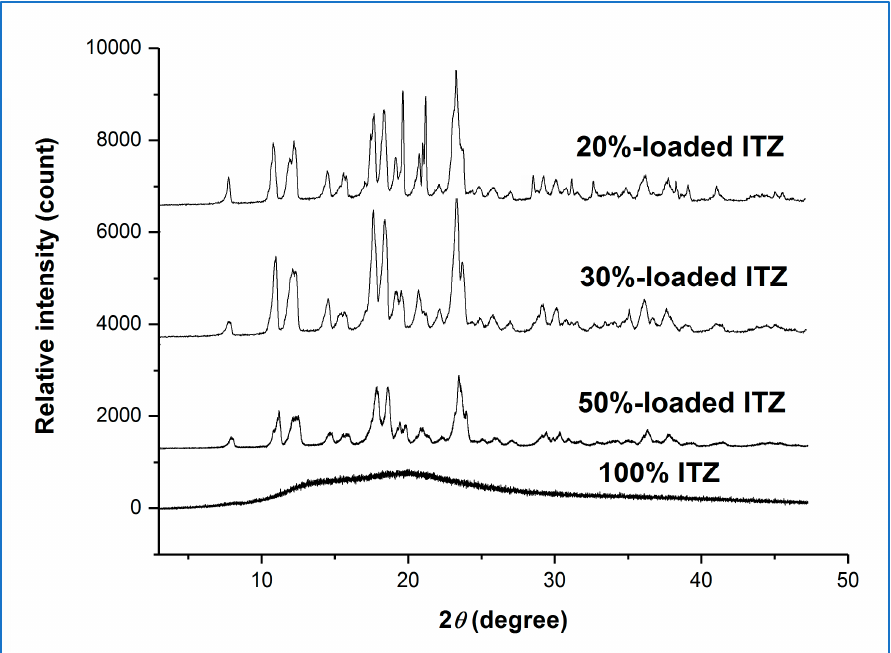
Figure 4. XRPD diffractograms of itraconazole-loaded sucrose microfibres (containing 20, 30, and 50% w / w itraconazole) and pure itraconazole microfibres after 30 days exposure to 25 °C/75% RH. (ITZ = itraconazole).